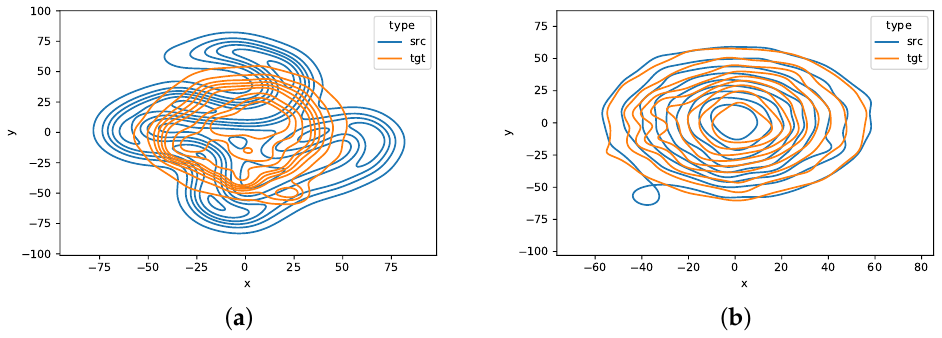
Figure 4. Bivariate kernel density estimation plots of representations. ( a ) The representations output by GLAT; ( b ) The representations output by SLSA. Source representation is denoted by a blue line, and the target is in orange. This figure shows that our model effectively pulled the source and target sentence-level semantic representations closer together.